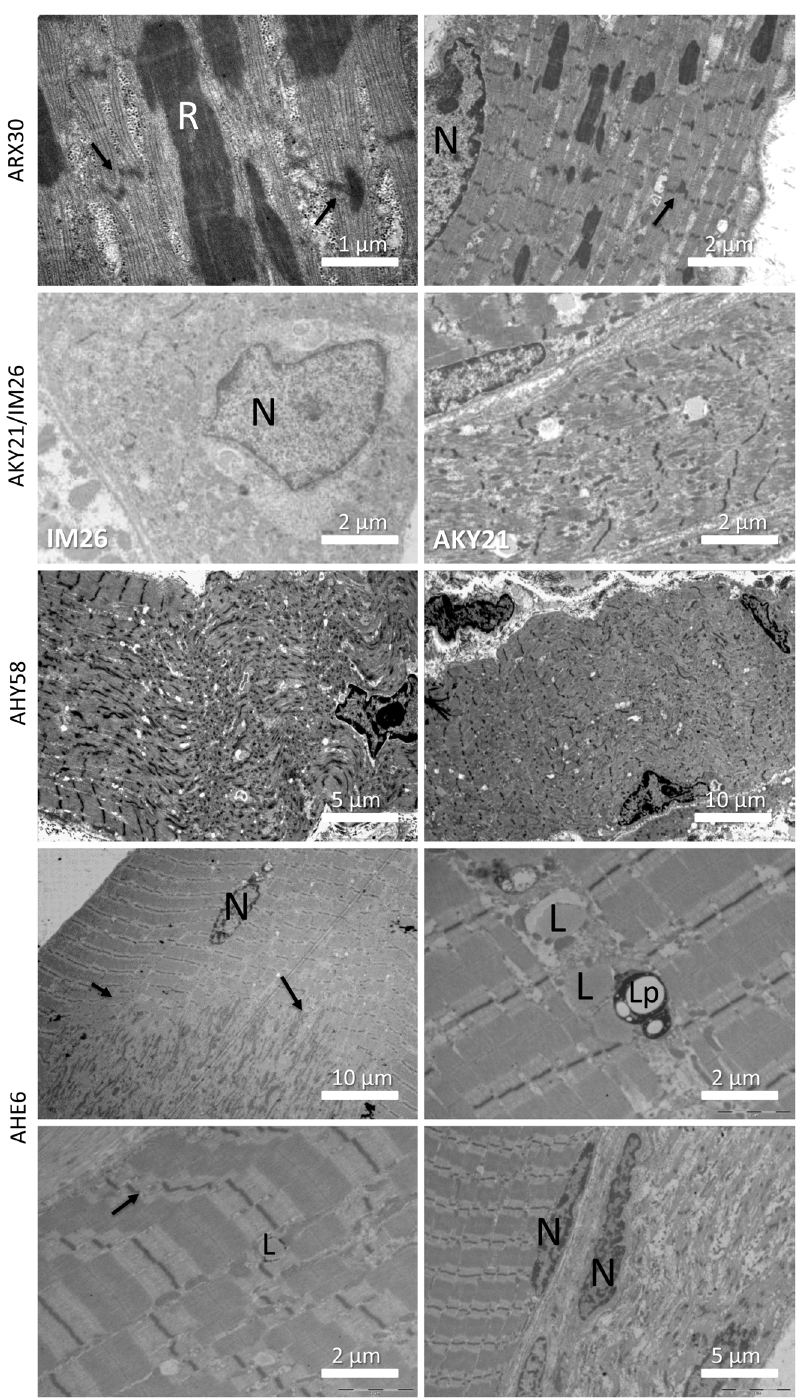
Figure 3. Ultrastructural analysis of muscle biopsies. Ultrastructural analysis of the biopsy from patient ARX30 revealed myofibrillar disorganization, Z-line streaming of adjacent sarcomeres (arrows), and prominent nemaline rods. The biopsy of patient IM26 showed large disorganized areas around internalized nuclei, the longitudinal muscle section of AKY21 revealed prominent Z-band streaming. Analysis of the biopsy of AHY58 demonstrated marked myofibrillar disorganization, fragmented Z-bands and internalized nuclei. The biopsy of patient AHE6 displayed nuclear centralization, myofibrillar disorganization, fibrosis, lipofuscin granules and myofiber degeneration. R = nemaline rods, N = nuclei, L = lipids, Lp = lipofuscin doi:10.1371/journal.pone.0067527.g003 However, exome sequencing does not detect intronic mutations The validation of the disease-causing mutations therefore requires and may generate a large list of variants of uncertain significance. the synergistic combination of the exome sequencing data with